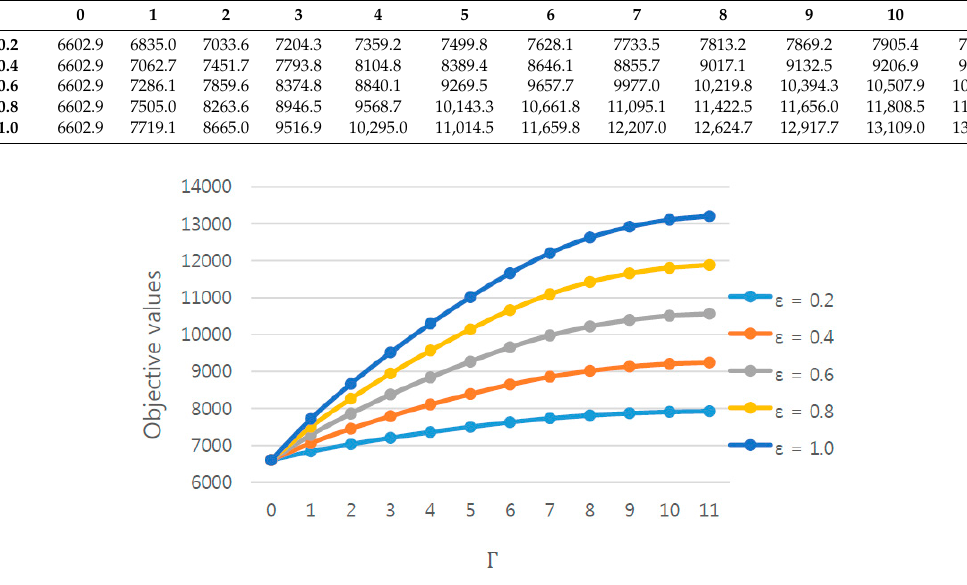
Figure 1. Objective values for different ε ( n = 12).